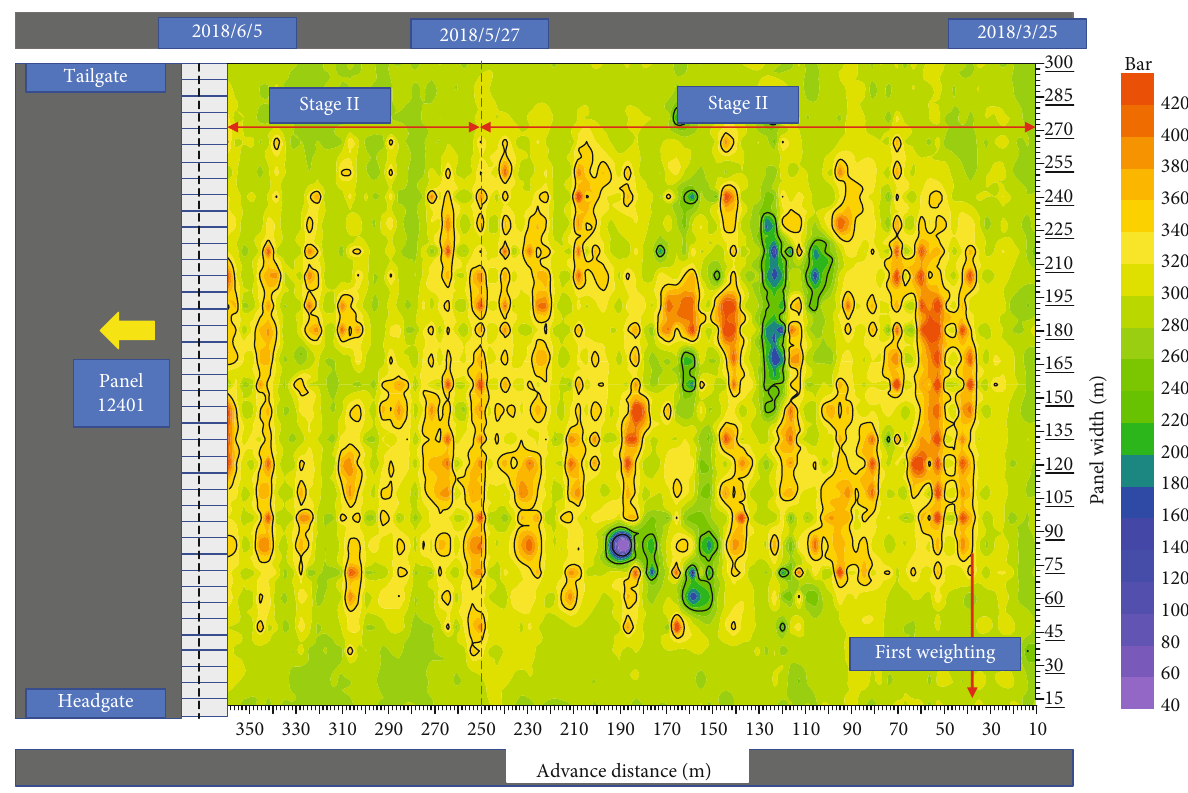
Figure 12: Distribution characteristics of the support working resistance of panel